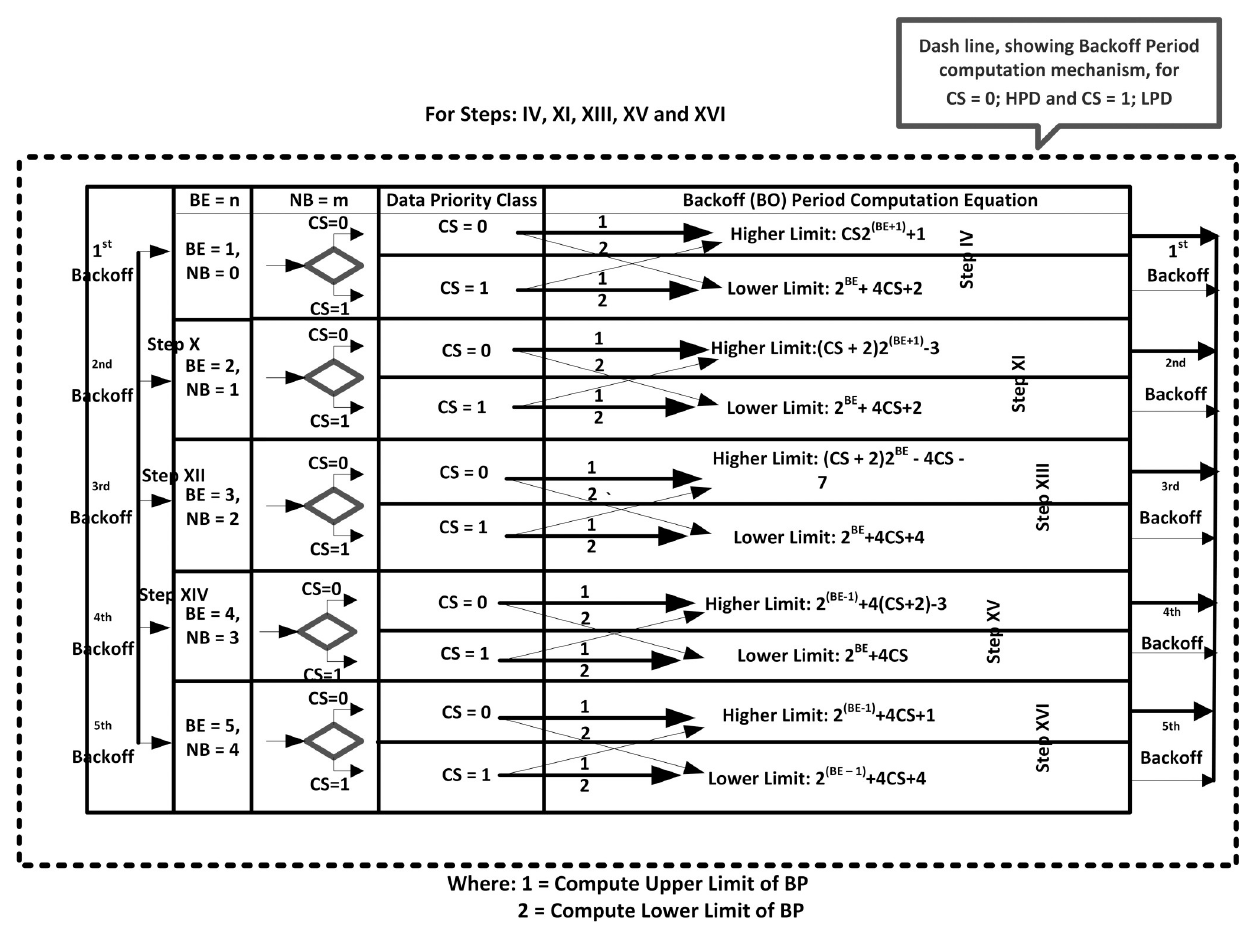
Fig 8. CSTP-MAC backoff period computation mechanism